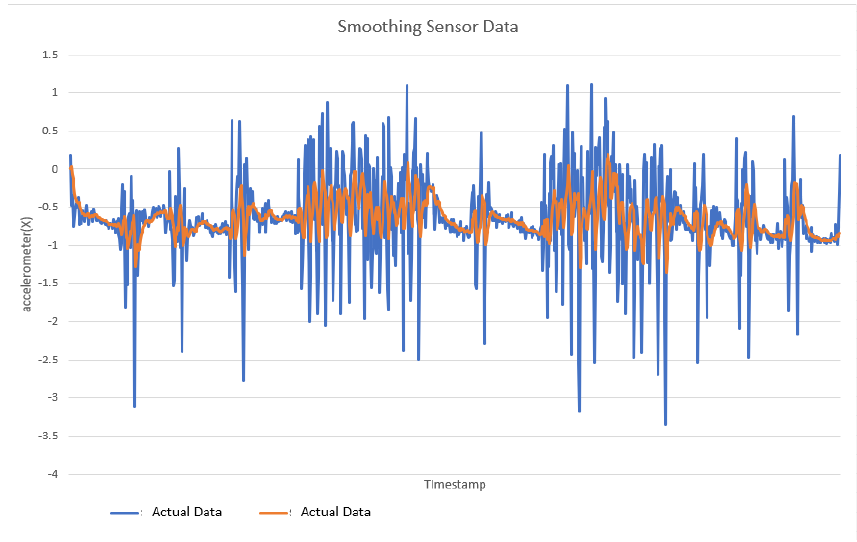
Figure 7. Exponential smoothing result.